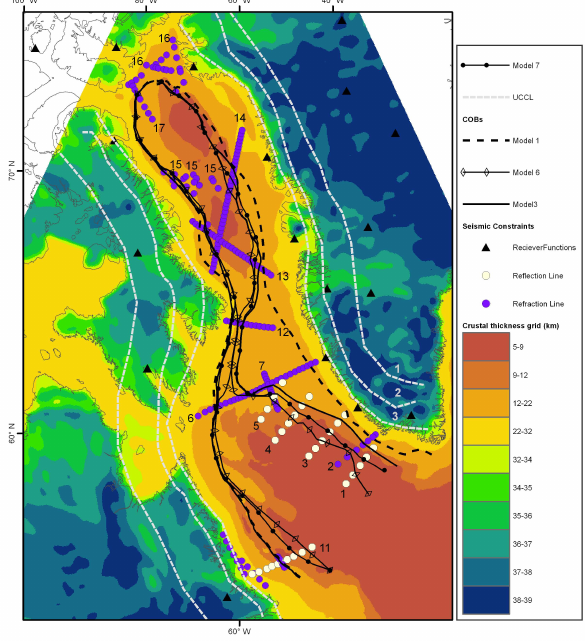
Fig. 7. Crustal thickness grid computed using the gravity inversion method. We defined three sets of UCCL for conjugate margins to examine the effect of changing the unstretched crust limit of re- stored COBs. UCCL number 1 is the most inland limit and corre- sponds to the crustal thickness ∼ 40km. Numbers 2 and 3 represent the limit of ∼ 37 and ∼ 34km respectively. The seismic line num- bers are the same as Fig. 1. Receiver functions on Greenland are from Dahl-Jensen et al. (2003). The North American receiver func- tions derived from Darbyshire (2003) and Ramesh et al.